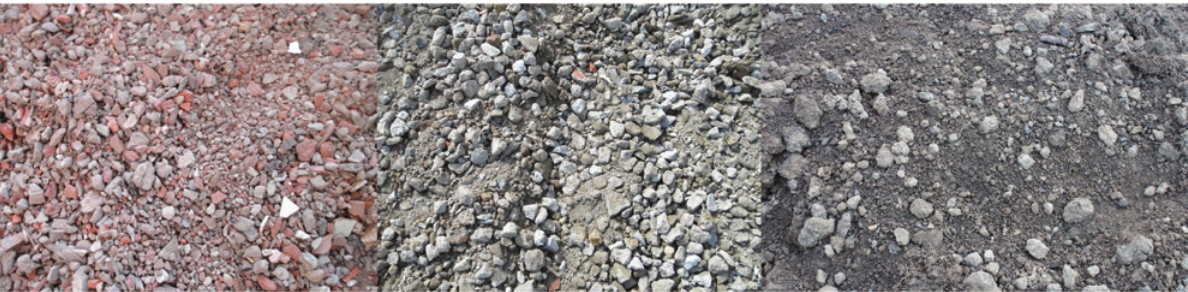
Figure 1: Samples of recycled bricks, recycled concrete, and soil with